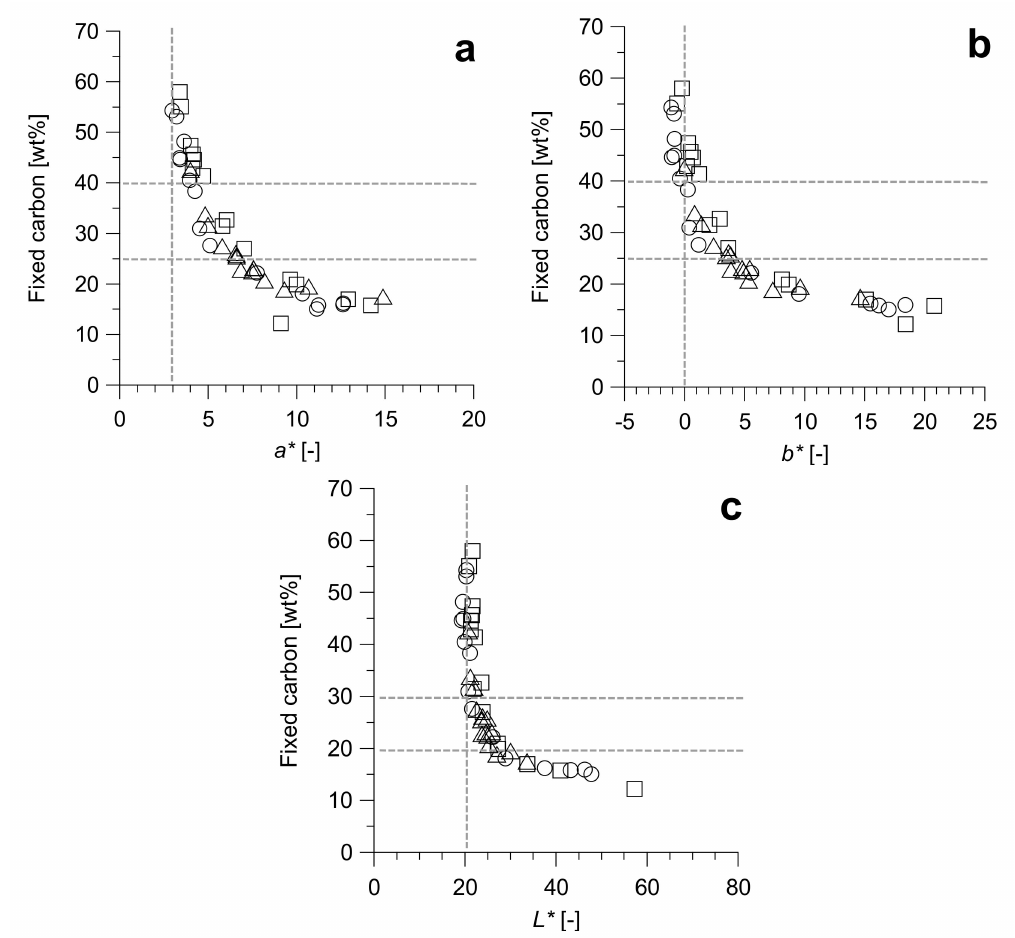
Figure 2. Correlation of the fixed carbon content of WB and ( a ) a * ; ( b ) b * ; and (c) L * values. Open circles = rubber tree; open triangles = softwood bark; open squares = softwood lumber